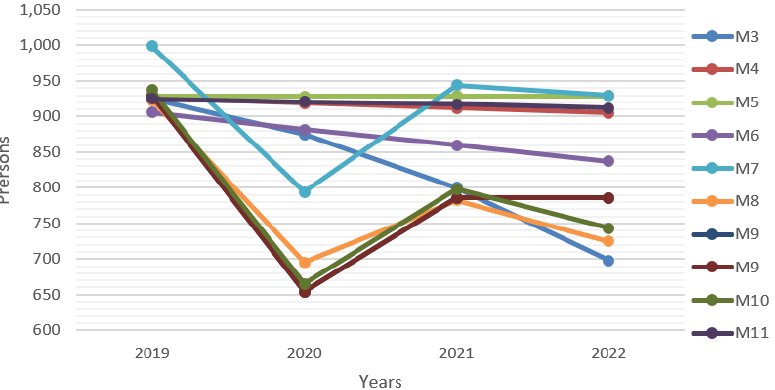
Figure 4. Forecasts of the number of victims of accidents at work in the steel industry in Poland in 2019–2022 for M3–M11 forecasting model.